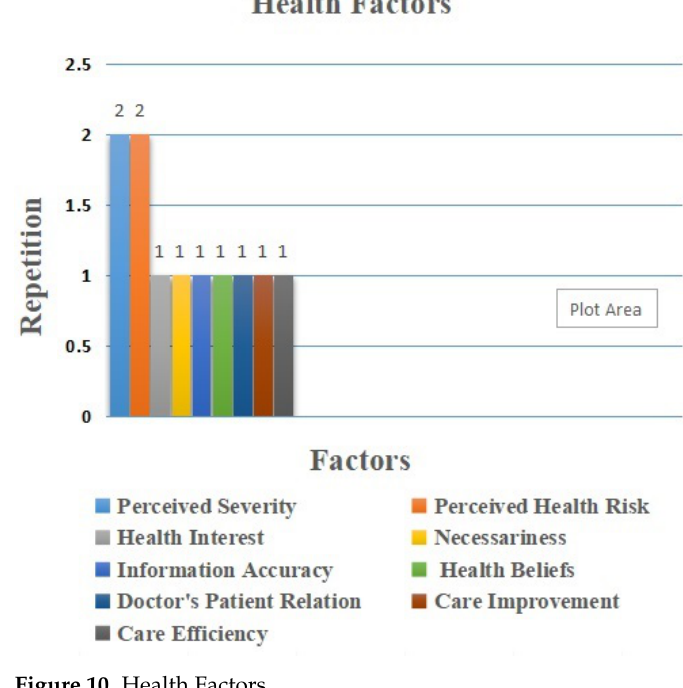
Figure 10. Health